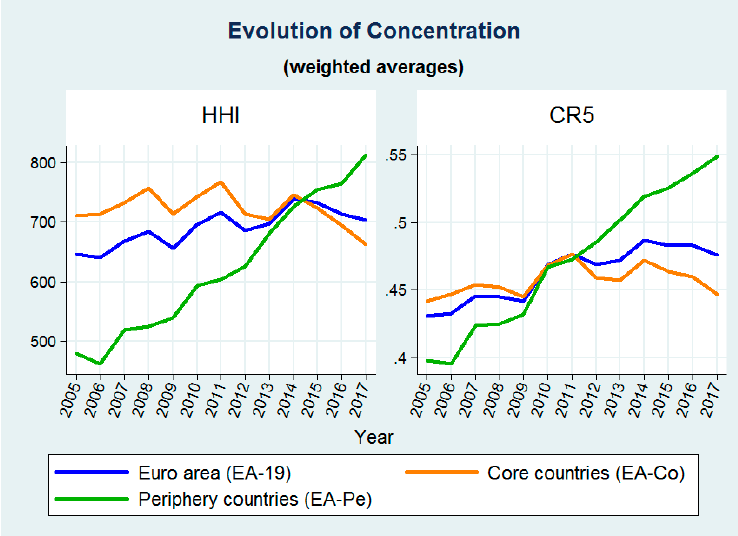
Figure 3. Evolution of bank concentration. Source: ECB, own calculations.